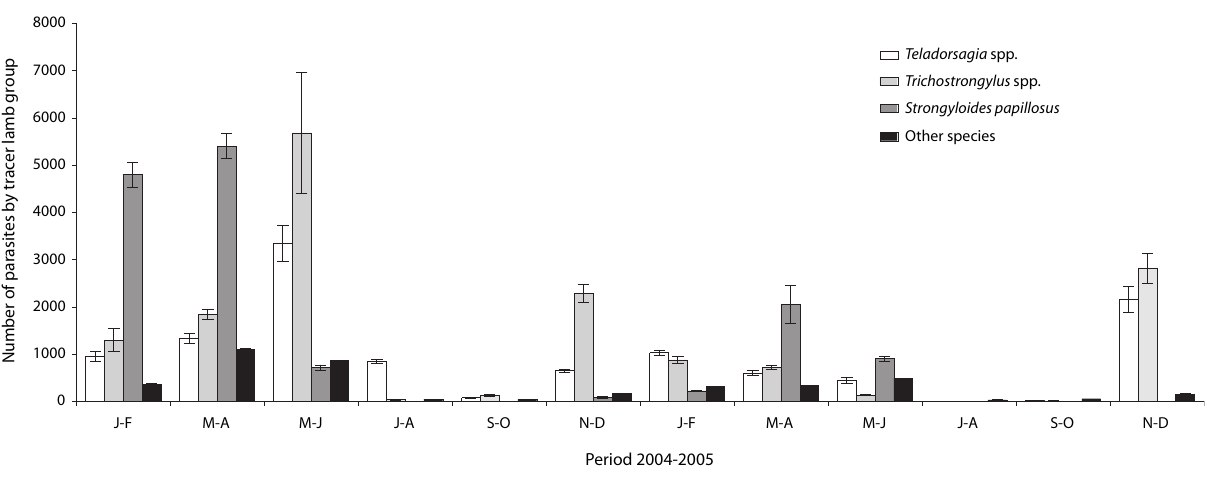
Fig. 2. – Bimonthly evolution of different gastrointestinal nematodes. Other species: Haemonchus contortus , Nematodirus spp., Cooperia oncophora , Trichuris spp., Chabertia ovina , Oesophagostomum venu- losum